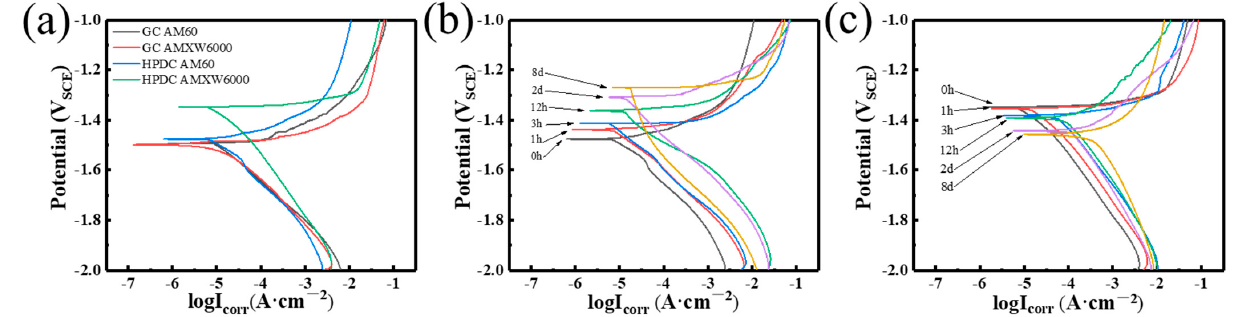
Figure 11. Linear polarization curves of ( a ) as-received GC and HPDC samples, ( b ) HPDCed AM60 and ( c ) AMXW6000 alloys, for different values of corrosion time.